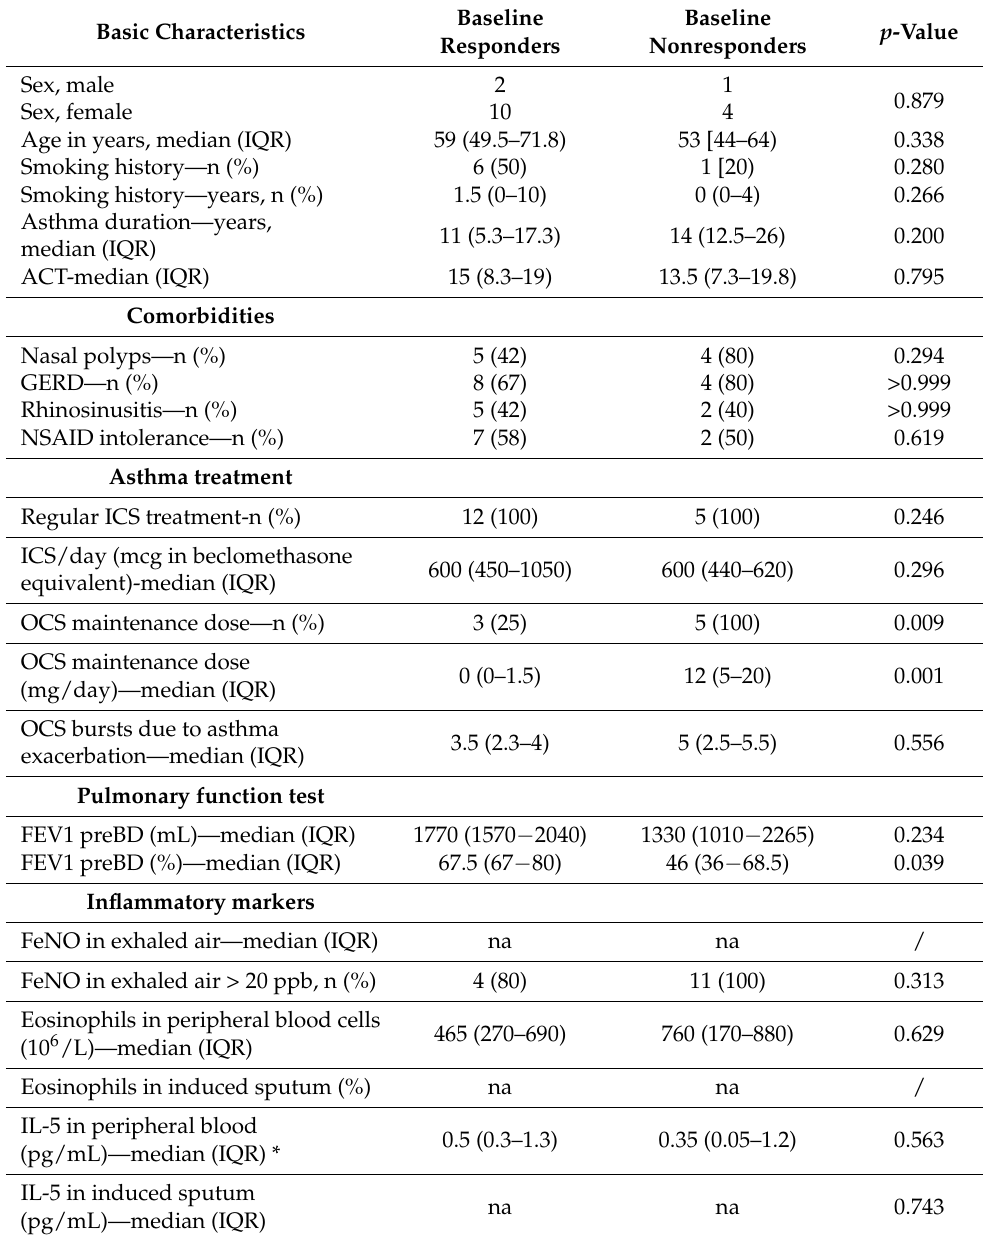
Table 1. Baseline characteristics of